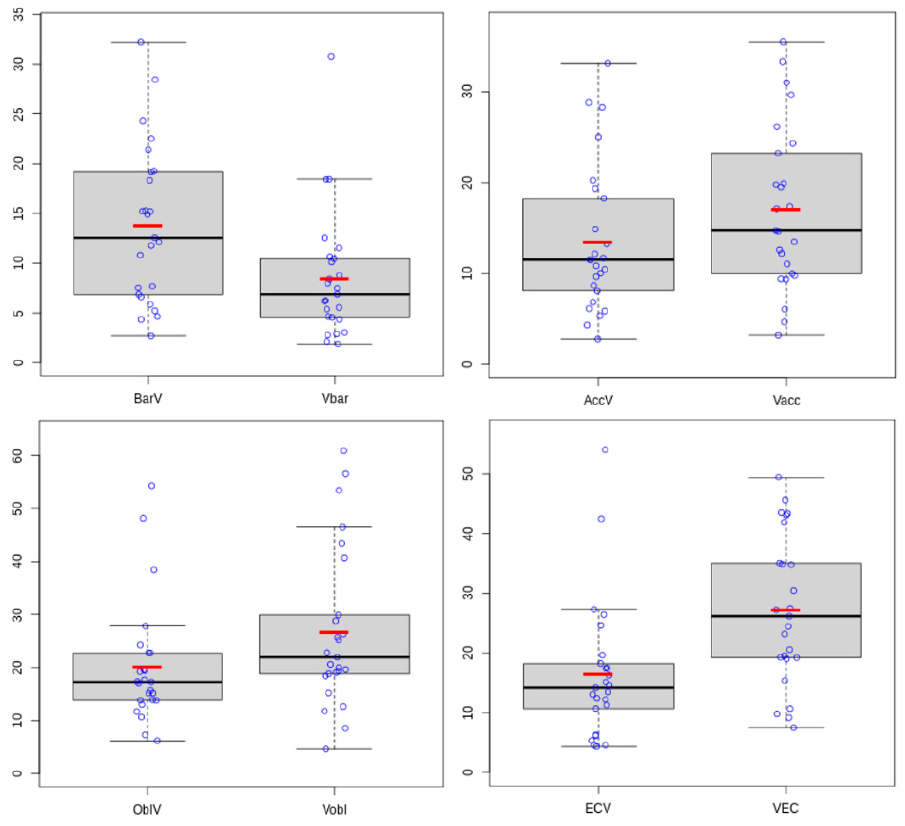
Figure 1. Comparison of XV versus VX orders.